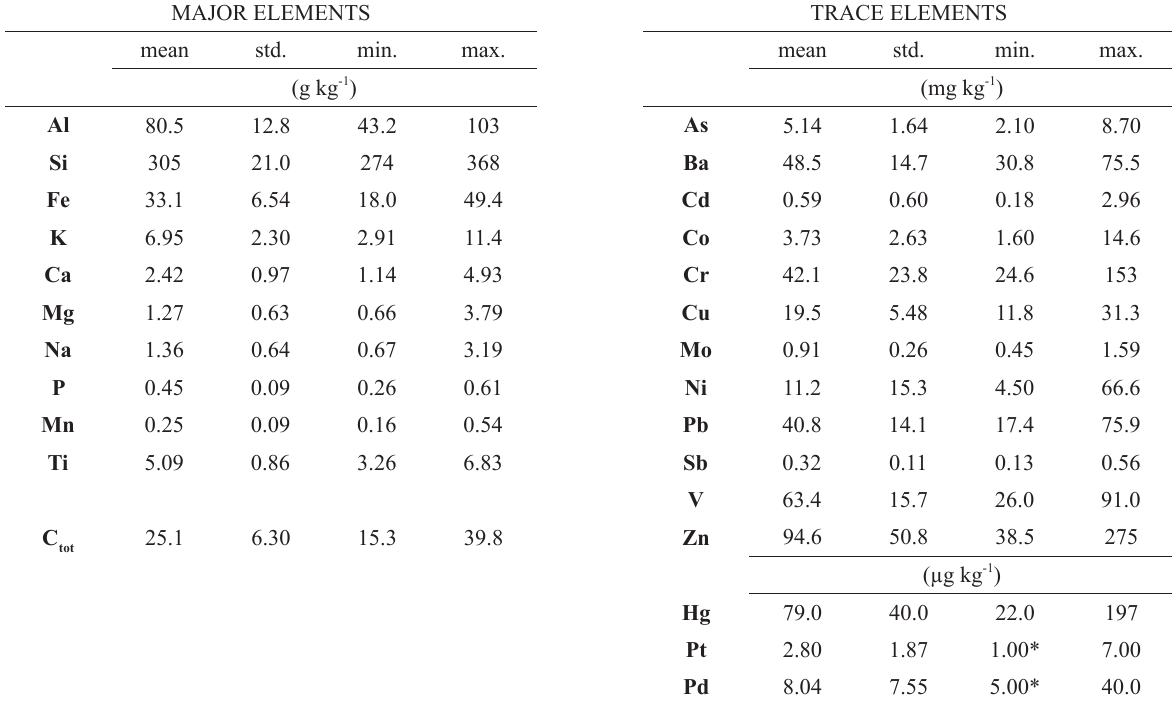
content in topsoils (min. - minimum; max.- maximum; std. - standard Major and trace elements and C tot